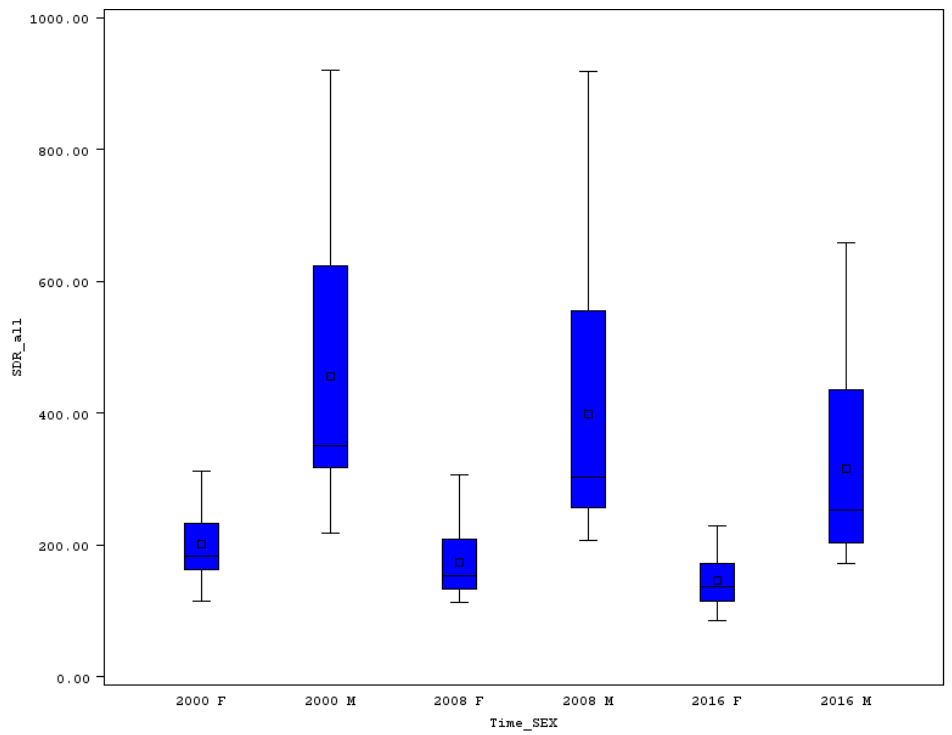
Figure 2. Boxplot of premature SDR in EU countries for males and females in selected years. Source: Own calculations based on Eurostat database